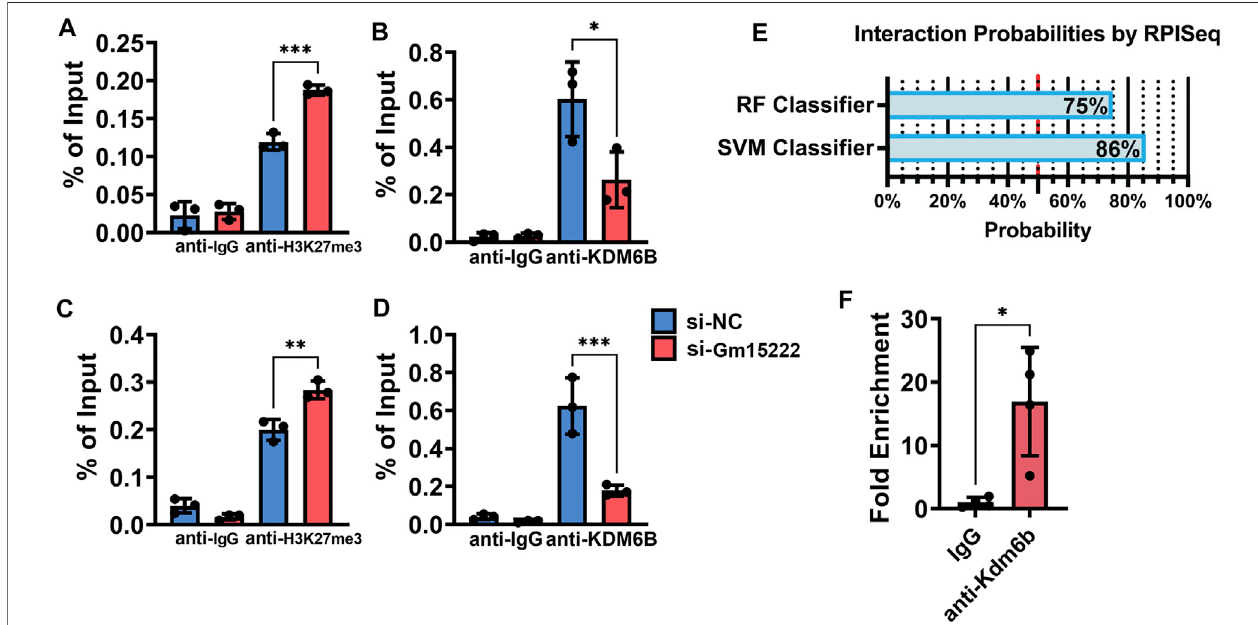
FIGURE 5 | Gm15222 recruits KDM6B and alters the histone methylation in the promoters of BMP4 and HOXC6. (A) Quanti fi cation of BMP4 from retrieved ChromatinofBMSCsintheprocessofmineralizationtreatedwithorwithoutsi-Gm15222inChIPassayusingH3K27me3antibody, n =3.SiNC,siRNAnegativecontrol. (B) Quanti fi cation of Bmp4 from retrieved Chromatin of BMSCs in the process of mineralization treated with or without si-Gm15222 in ChIP assay using Kdm6B antibody. (C) Quanti fi cation ofHoxC6 from retrieved ChromatinofBMSCsinthe process ofmineralizationtreated with orwithoutsi-Gm15222inChIP assayusing H3K27me3 antibody, n = 3. (D) Quanti fi cation of HoxC6 from retrieved DNAs of BMSCs in the process of mineralization treated with or without si-Gm15222 in ChIP assay using Kdm6B antibody, n = 3. (E) The interaction possibilities of Gm15222 and Kdm6b from RPISeq. (F) Quanti fi cation of Gm15222 from retrieved RNAs of BMSCs in RIP assay using Kdm6b antibody, n = 4. Data were shown as mean ± S.D., a two-tail t -test was used to test for those data between two groups, and a one- way ANOVA with Tukey ’ s post hoc test was used to test those data between more than two groups. * p < 0.05; ** p < 0.01; *** p < 0.001; **** p < 0.0001.